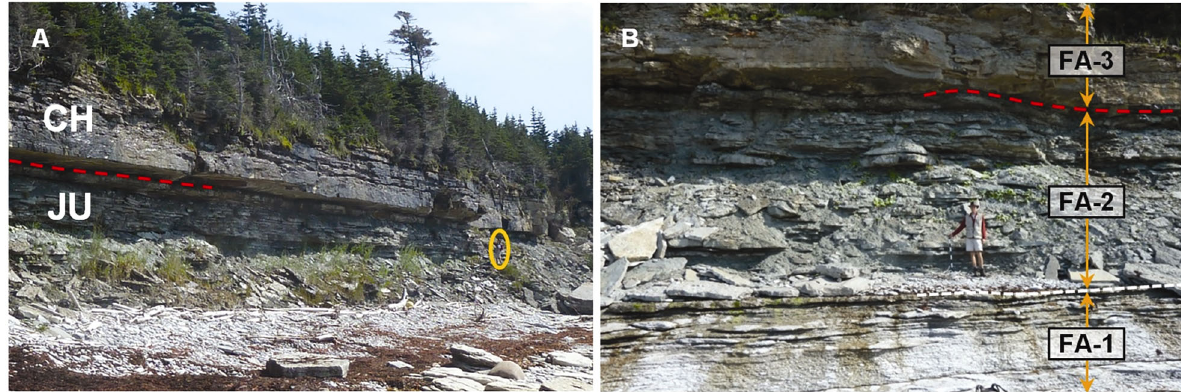
Fig. 2. Exposures of the Jupiter(cid:150)Chicotte formational boundary exposed along the coastal Jumpers section, in the south-central part of Anticosti Island. Person for